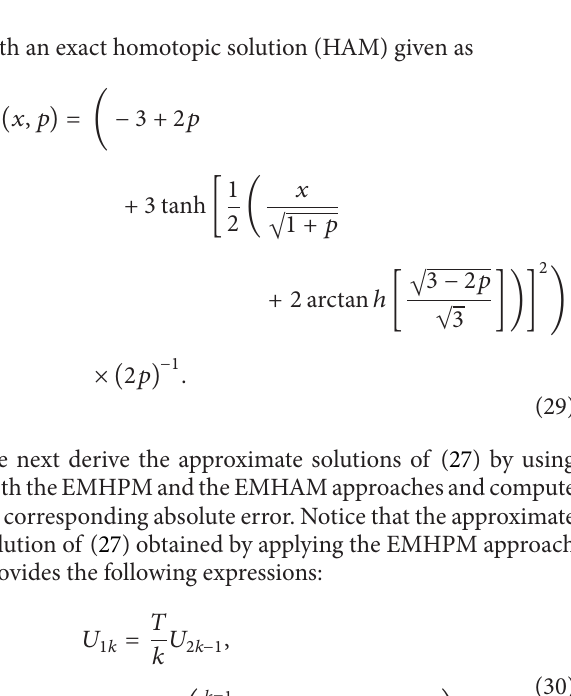
Figure 4: Absolute error plotted against the control parameter ℎ .